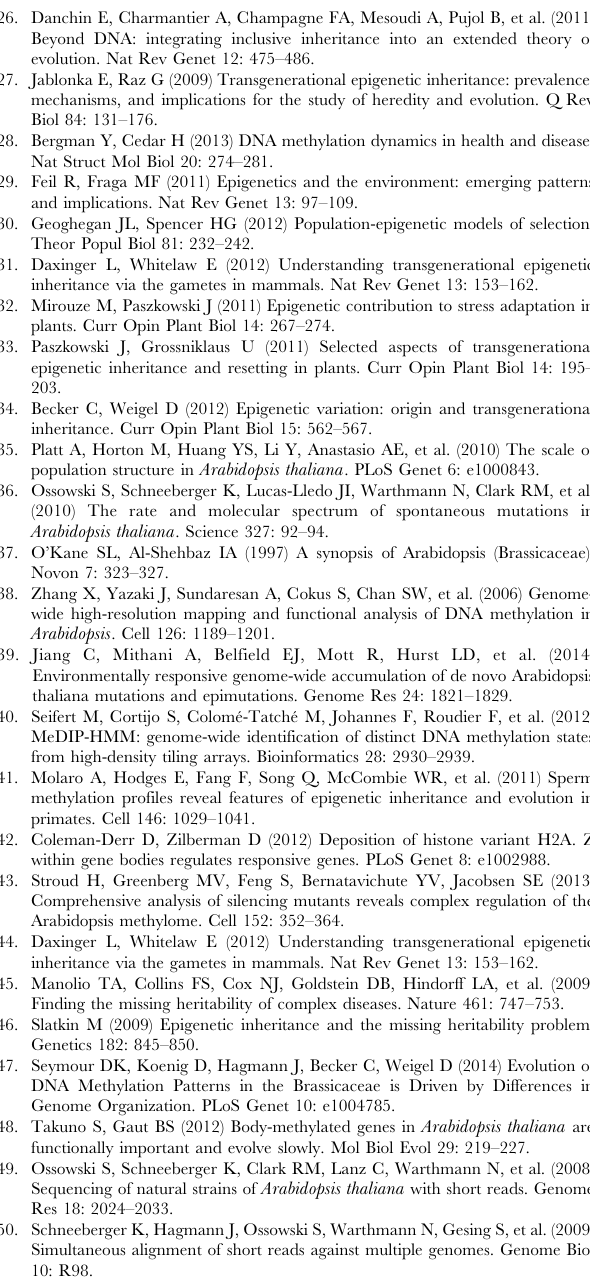
S11 Table Statistics of overlapping DE genes and hDMRs. S12 Table Overlap of SVs with MRs in HPG1 and Col-0 in different genomic features. S13 Table Scoring matrices for SNP calling and assessing cytosine site statistics (for bisulfite